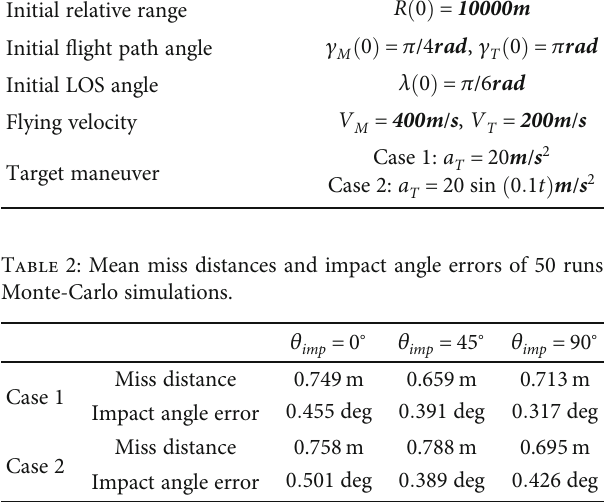
Table 1: Required data for initializing simulations. Parameter